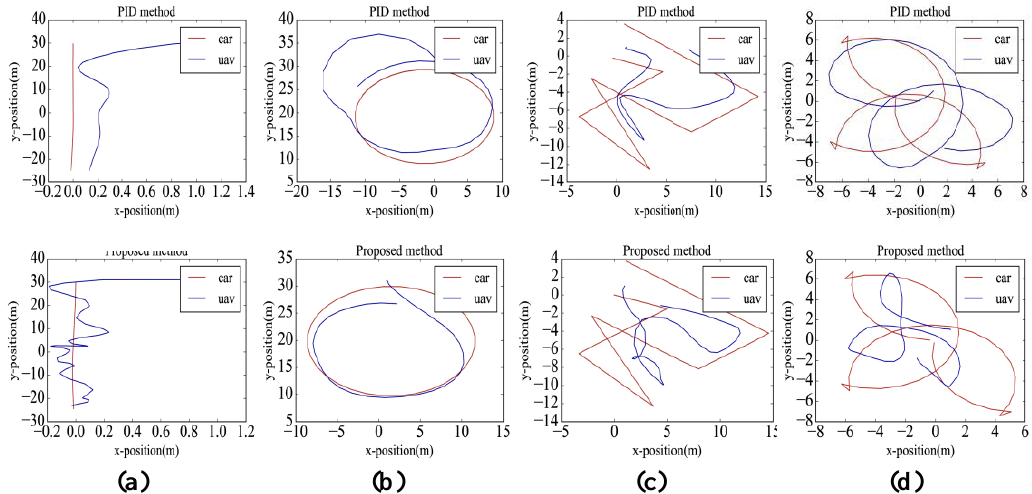
Figure 7. Trajectory of UAV while tracking a moving platform: moving platform for ( a ) linear motion, ( b ) circular motion, ( c ) random motion, and ( d ) random motion.